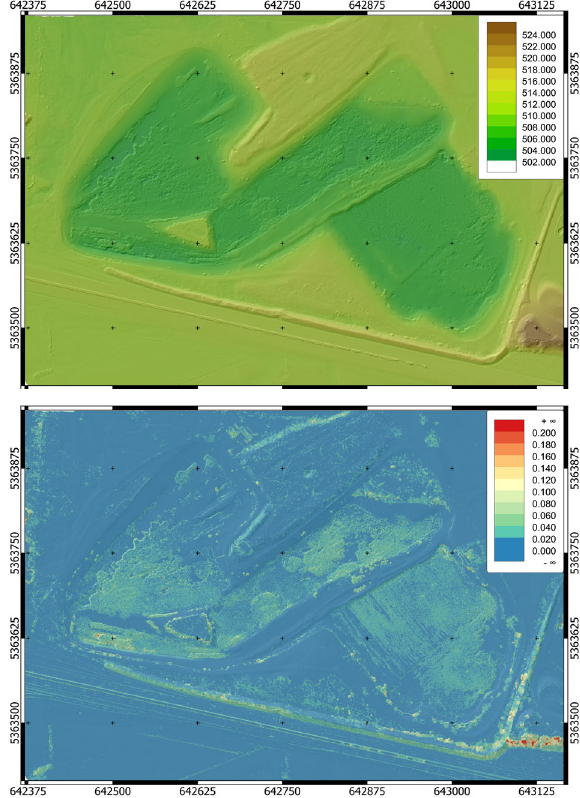
Figure 6. DTM of Lake Autobahnsee containing bare land surface and submerged topography; top: color coded elevation map superimposed with shaded relief map; bottom: color coded height precision map ( σ z ) thus, enabling multi-target detection for plants with a height less than 0.5m. In addition to the laser data, the concurrently ac- quired Coastal Blue and RGB image data are of further use for (cf. Figure 9